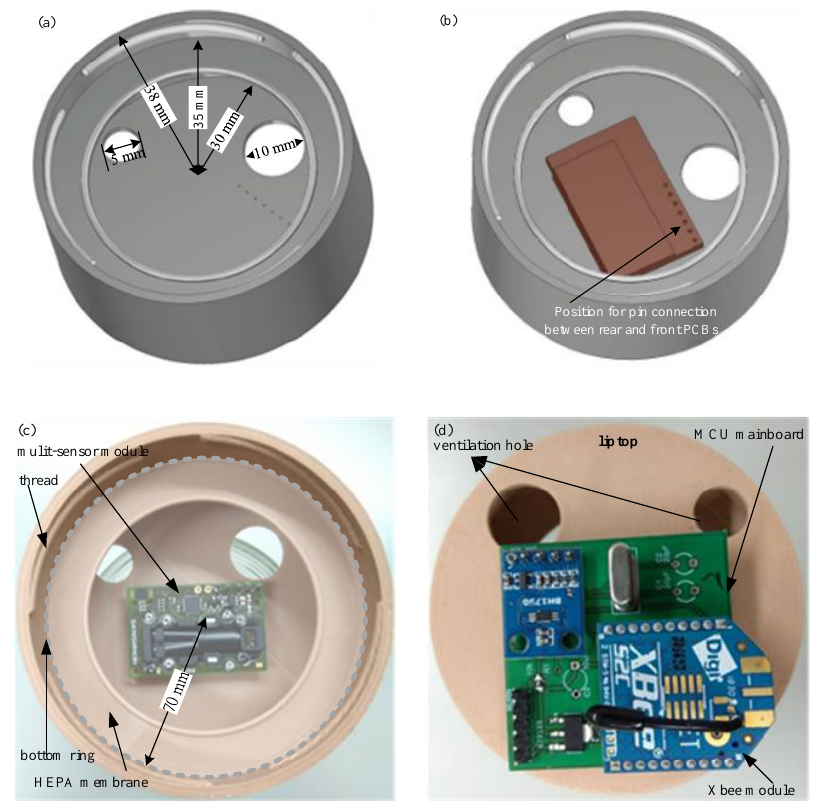
Figure 3. Schematic of jar lid. ( a ) Layout; ( b ) multisensor module arrangement; ( c ) rear-view and ( d ) front-view prototype photographs of hardware implementation for proposed multisensor module.